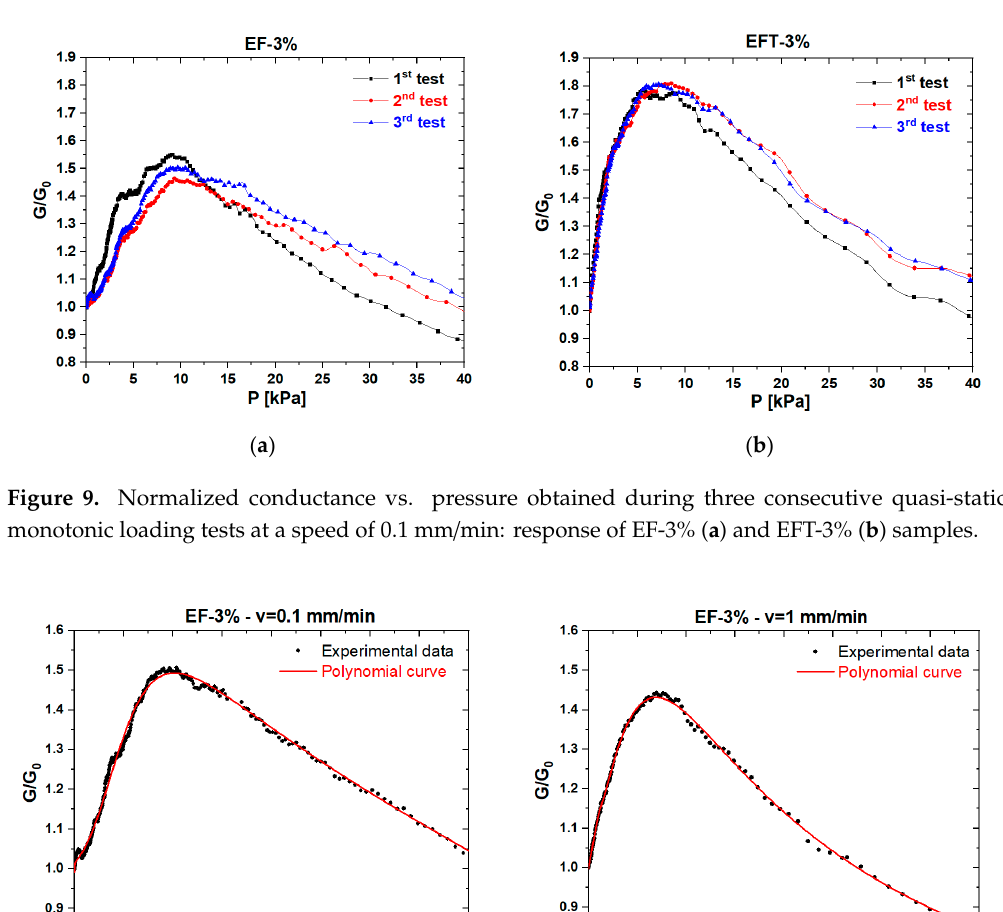
Figure 8. Image of the electromechanical setup.